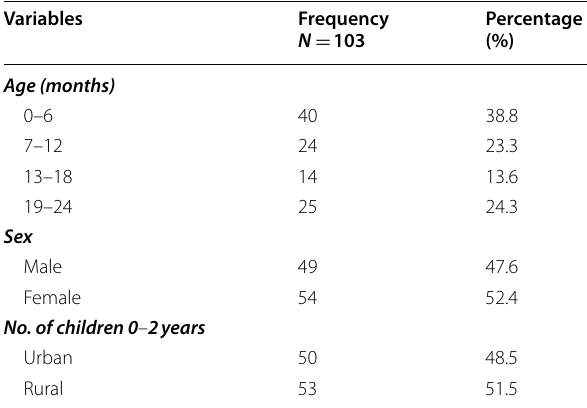
Table 1 Demographic characteristics of the pre-school aged children